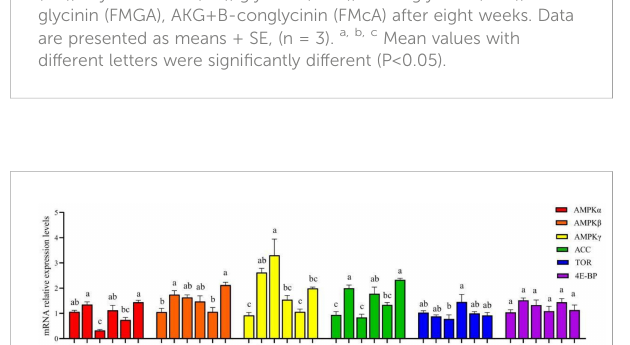
FIGURE 6 Relative expression levels of AMPK/ACC and TOR signaling pathways in the intestine of mirror carp at different treatments fed with diets containing fi shmeal (FM), soybean meal (SM), glycinin (FMG), B- conglycinin (FMc), AKG+ glycinin (FMGA), AKG+B-conglycinin (FMcA) after eight weeks. AMPKa, AMP-activated protein kinase gamma; ACC, acetyl-CoA carboxylase; TOR, target of rapamycin; 4E-BP, eIF4E-binding protein. Data are presented as means + SE, (n = 3). a, b, c Mean values with different letters were signi fi cantly different